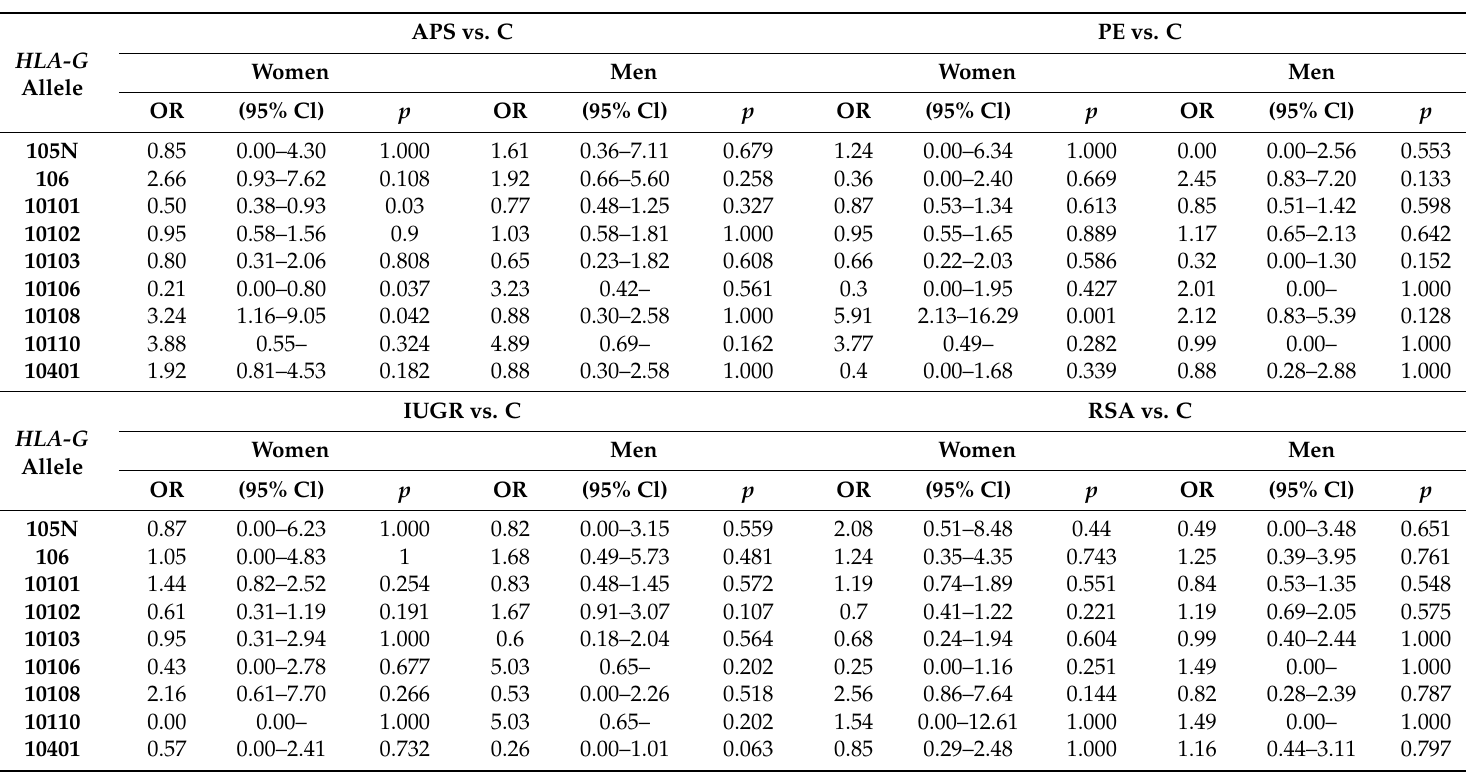
Table 5. The HLA-G allele frequencies in the women with antiphospholipid syndrome (APS), preeclampsia (PE), intrauterine growth restriction (IUGR), recurrent spontaneous abortion (RSA), and their partners. The risk of APS, PE, IUGR, and RSA in these women and in the control group (C). APS vs. C PE vs. HLA-G Allele